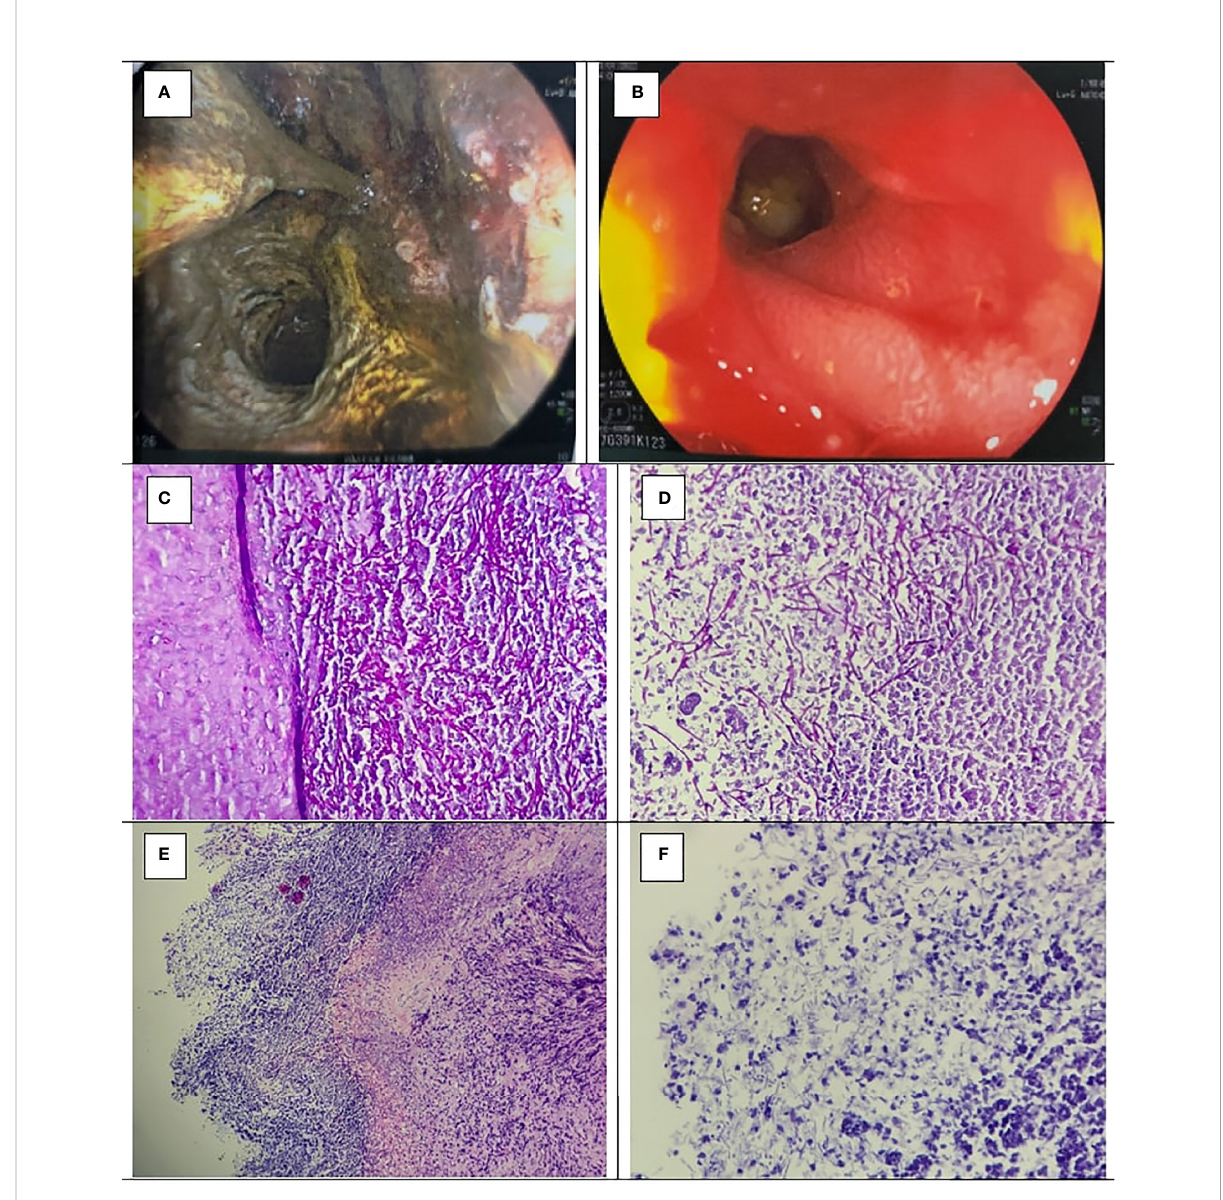
FIGURE 4 (A) Gastrojejunostomosis stenosis con fi rmed by gastrointestinal endoscopy. (B) The gastrojejunostomosis was good response after 2 weeks of Fluconazole prophylaxis. PASx400 (C, D) , HEx100 (E) , and Hex400 (F) showed Candida spores and budding hyphae invading and destroying adjacent gastric wall, and surrounding non-speci fi c in fl